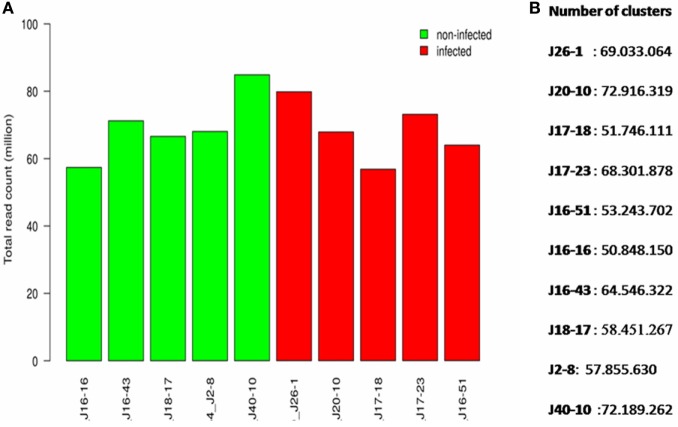
The score quality of different sequences of clusters, presented base by base. Green indicates a good quality. (A) Total read count per sample (millions). (B) Number of clusters per sample.